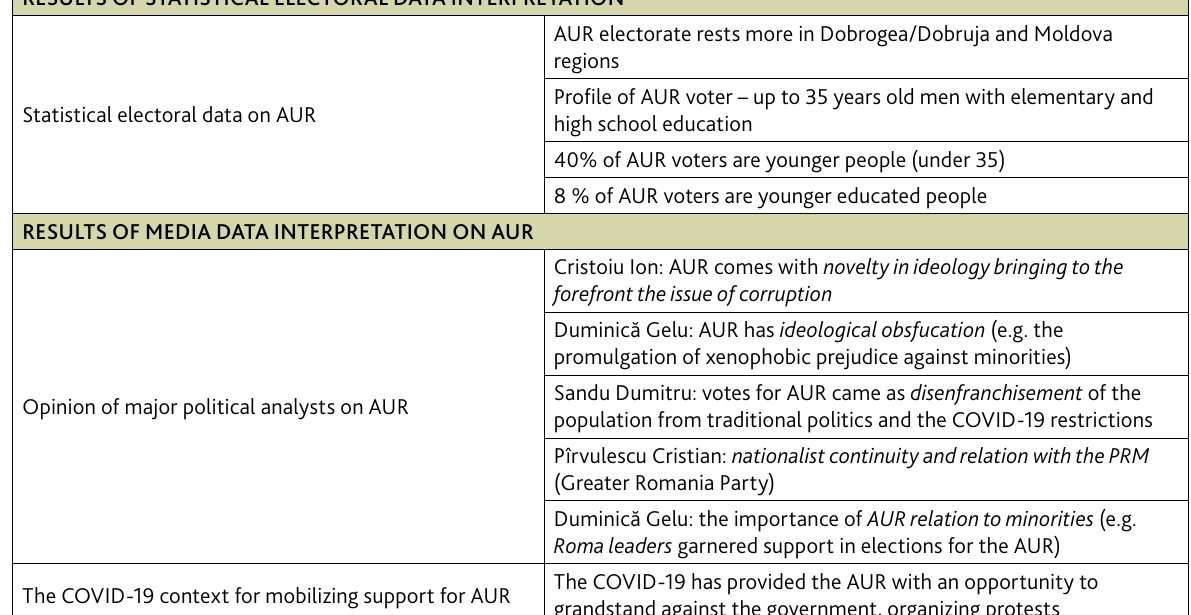
Table 2. Results summary RESULTS OF STATISTICAL ELECTORAL DATA